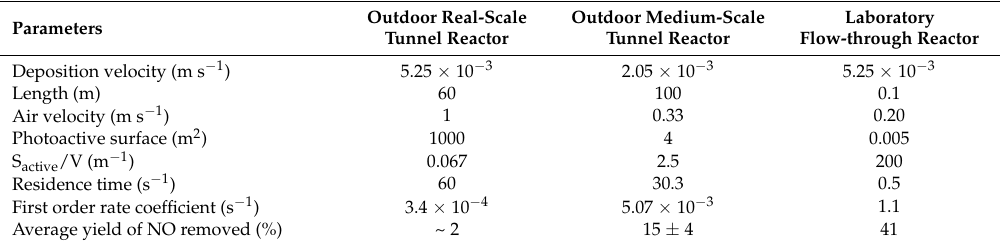
Table 14. Parameters and results of NO removal in a medium-scale tunnel reactor (UVA irradiance, >40 W m − 2 ; relative humidity, <30%; dimensions, 0.4 × 0.4 × 10 m; photoactive surface, 0.4 × 10 m) compared to a real-scale tunnel and a small laboratory flow-through